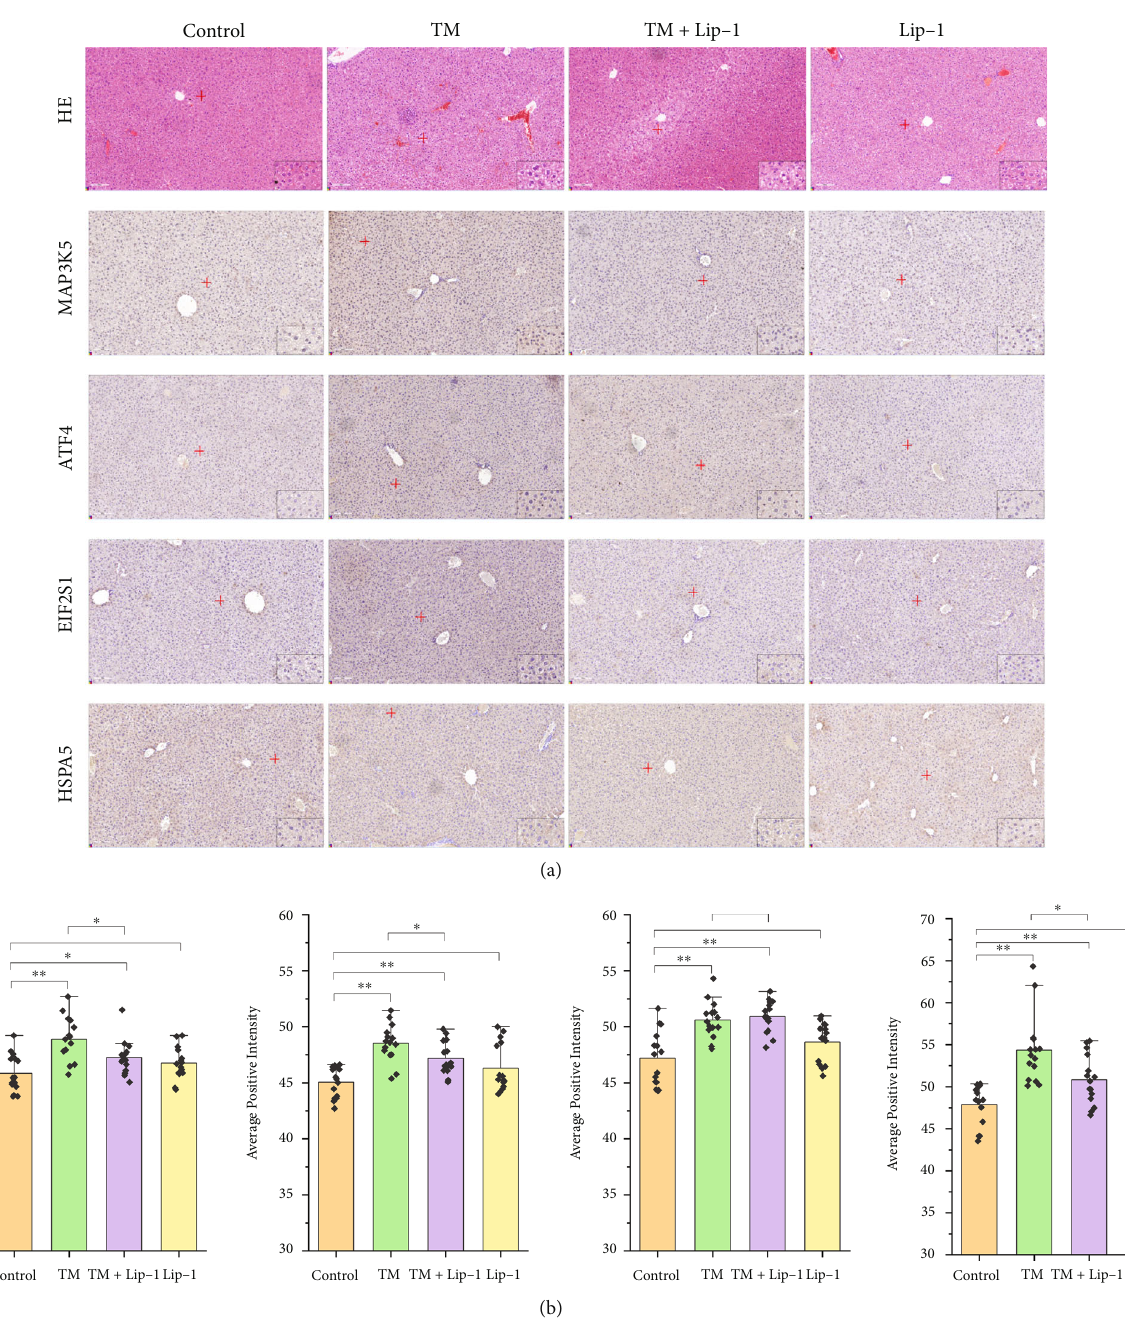
Figure 6: Validation results of ATF4, EIF2S1, HSPA5, and MAP3K5. (a) HE and immunohistochemistry of liver tissue under di ff erent groups (magni fi cation, × 200; scale bar, 100 μ m; red + marks the position of the magni fi ed image in the lower right corner of the fi gure); (b) average positive intensity statistics of immunohistochemistry of ATF4, EIF2S1, HSPA5, and MAP3K5 (data presented as the mean ± standard deviation ( n = 15 ); LSD in one-way ANOVA was selected for pairwise comparison, ** P < 0 : 01 , * 0 : 01 < P < 0 : 05 , unmarked *means P > 0 : 05